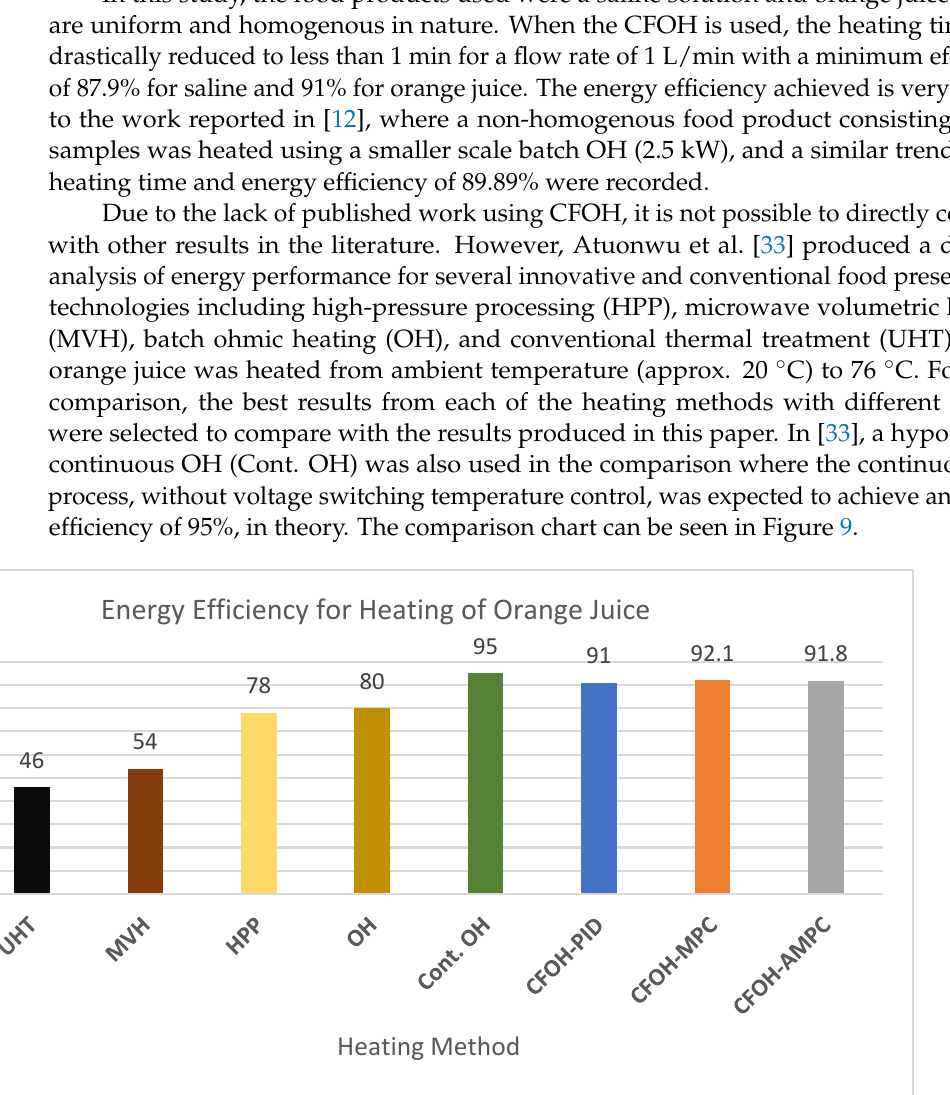
Figure 9. Energy efficiency comparison with different heating methods. Note: the first 5 data were quoted from [33].